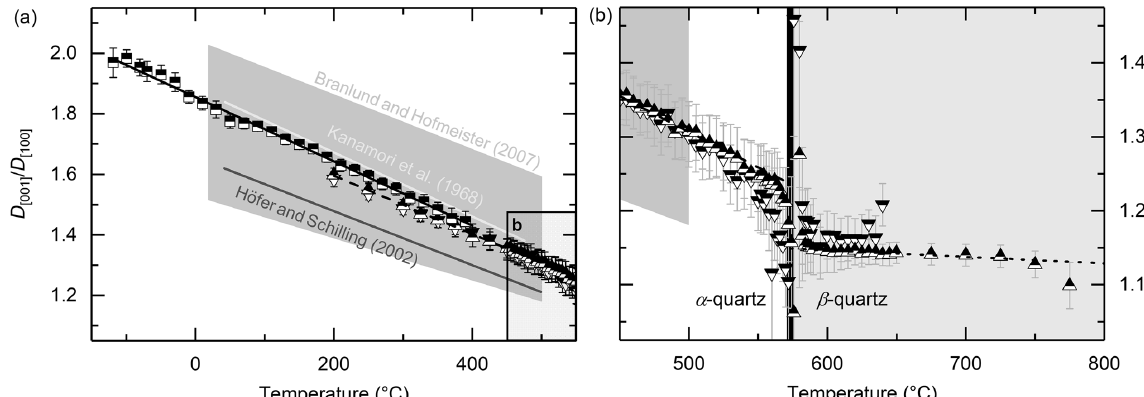
Figure 3. Anisotropy of the single-crystal thermal diffusivity of quartz shown as ratio D [ 001 ] /D [ 100 ] for measurements at low (squares; a ) and high temperatures (upwards triangles for specimens HT1, downwards triangles for HT2, for T ≥ 200 ◦ C). The α – β phase transition zone is shown enlarged in panel (b) . Solid and dashed black lines represent linear fits to α phase data for T ≤ 510 ◦ C and to β phase for T = 585–750 ◦ C ( b ; dotted black